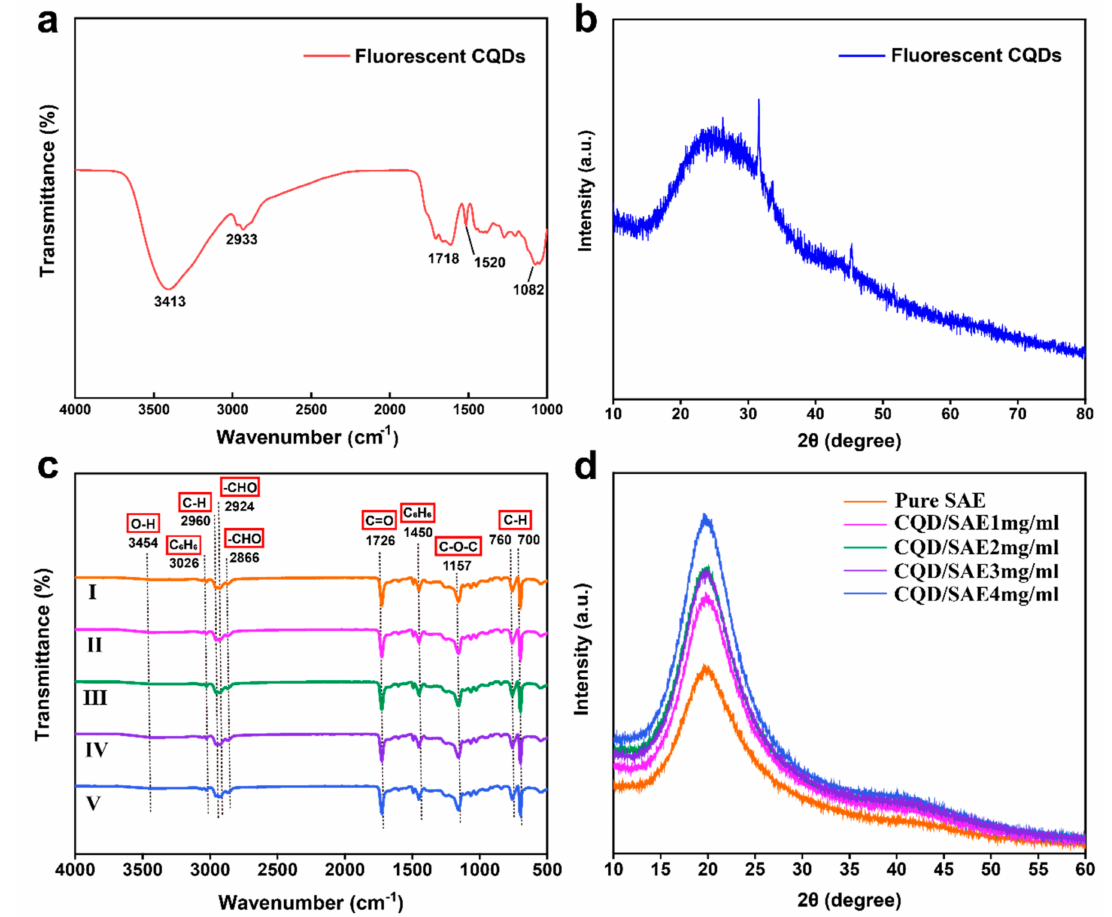
Figure 3. ( a ) FT − IR spectrum of fluorescent CQDs. ( b ) XRD result of fluorescent CQDs. ( c ) FT − IR spectra of pure SAE and CQD/SAE coating films. ( d ) XRD patterns of pure SAE and CQD/SAE coating